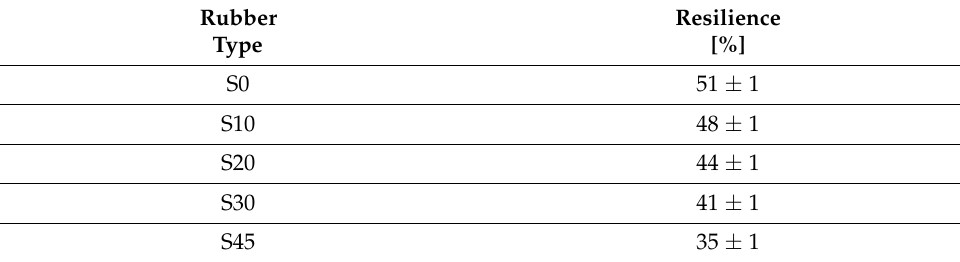
Table 3. Values of rebound resilience of the tested rubber composites.